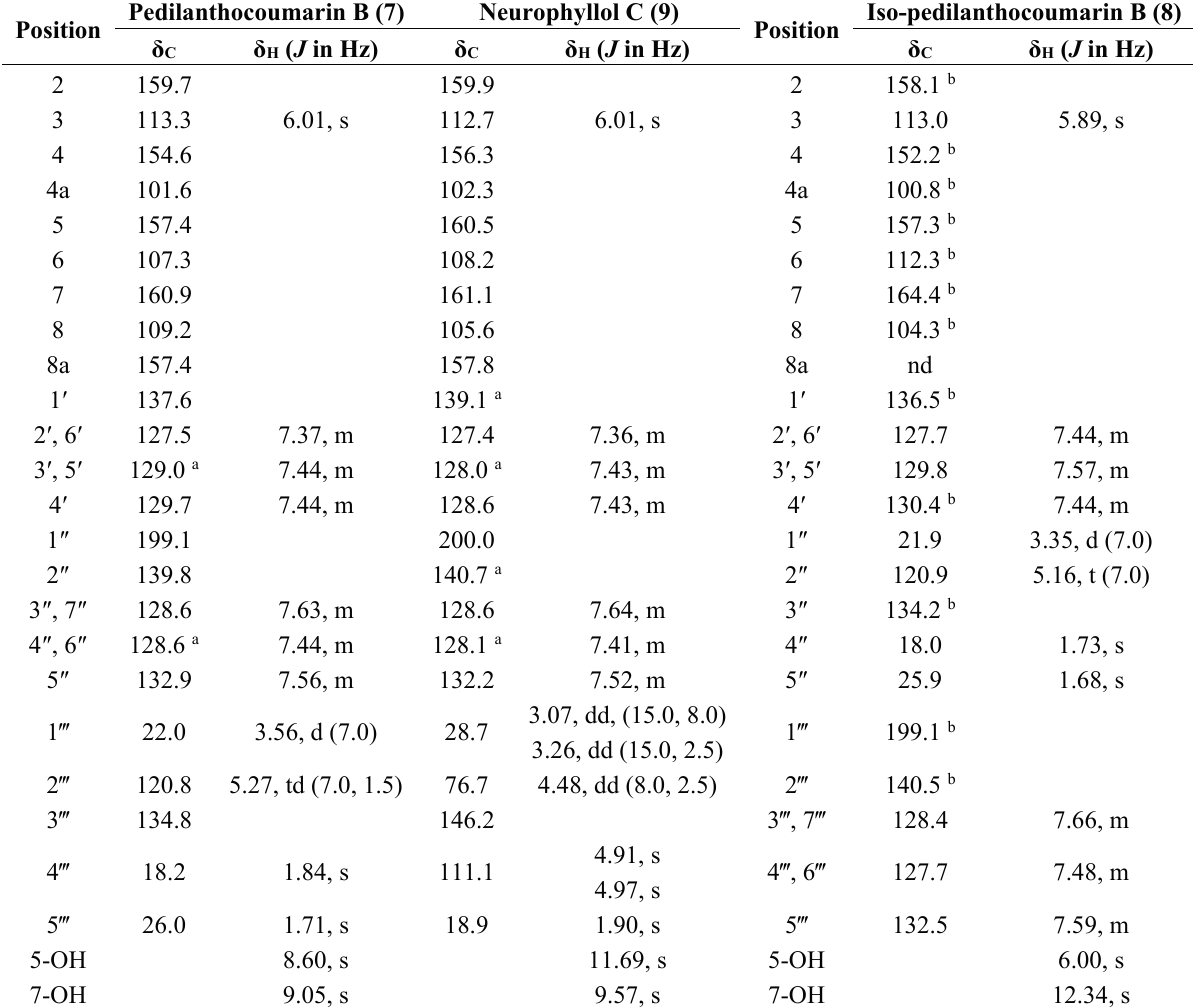
Table 2. 1 H- (500 MHz, CDCl 3 ) and 13 C-NMR (125 MHz, CDCl 3 ) data for pedilanthocoumarin B ( 7 ), iso-pedilanthocoumarin B ( 8 ) and neurophyllols C ( 9